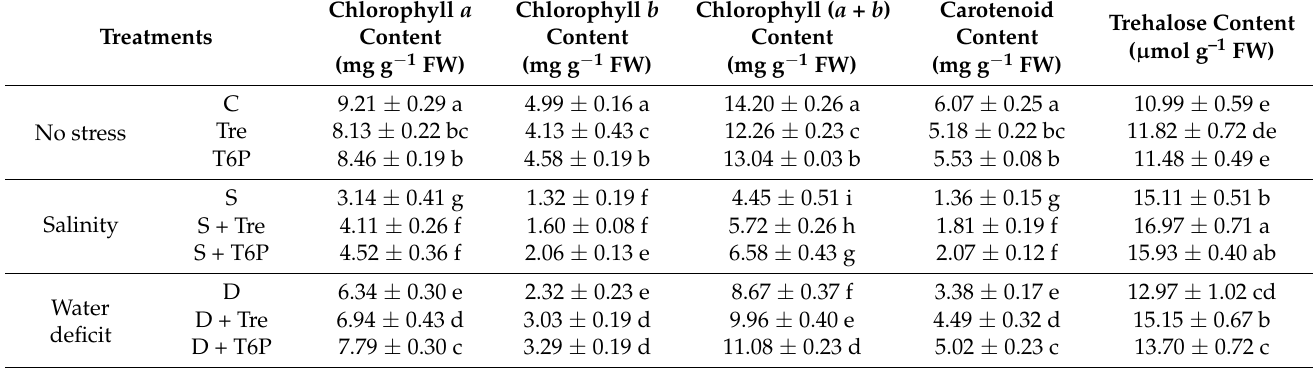
Here, C, control; Tre, 200 µM trehalose; T6P, 200 µM trehalose 6-phosphate; S, NaCl treatment; D, water deficit treatment with PEG 6000.